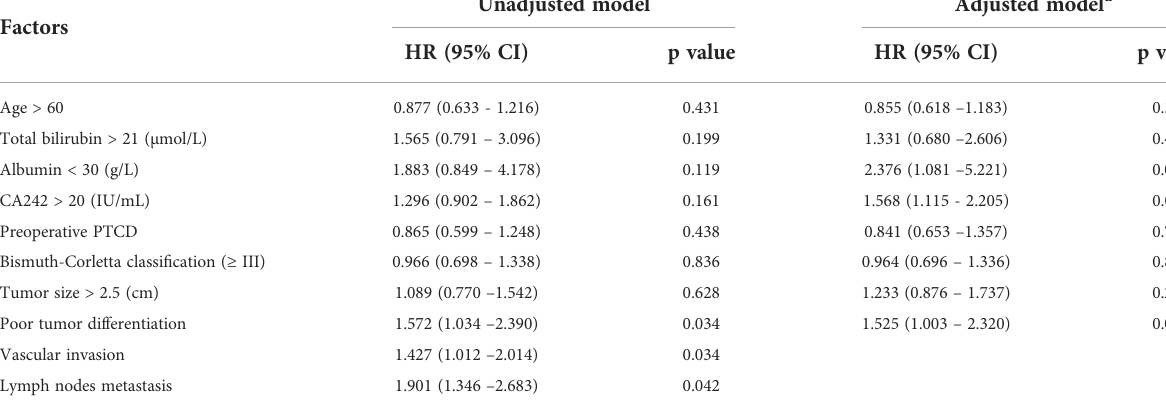
TABLE 5 Multivariable analysis of risk factors associated with relapse-free survival.